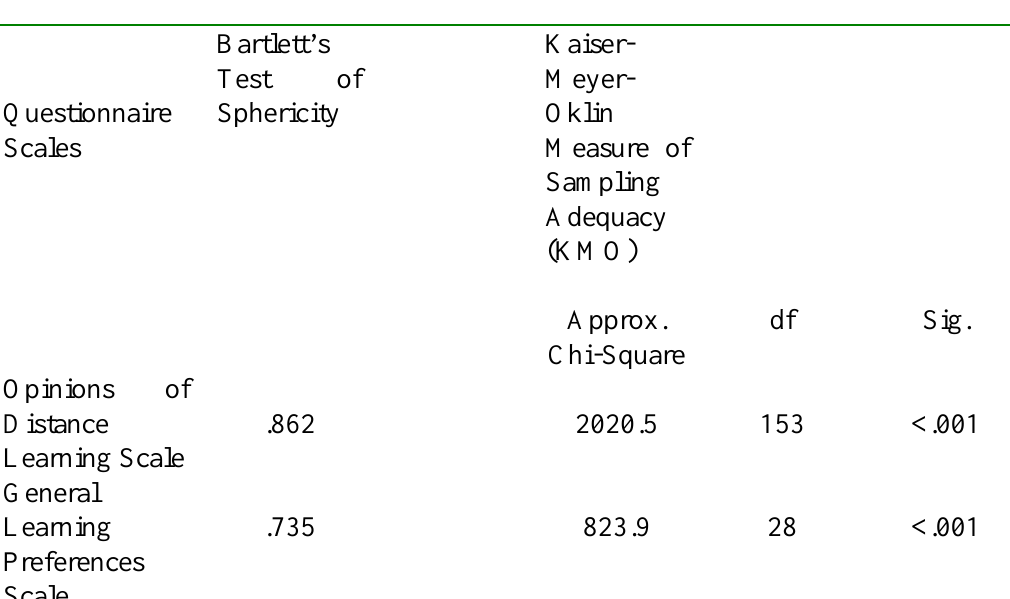
Table A3. KMO and Bartlett’s Test for Suitability for Factor Analysis Tests of Suitability for Factor